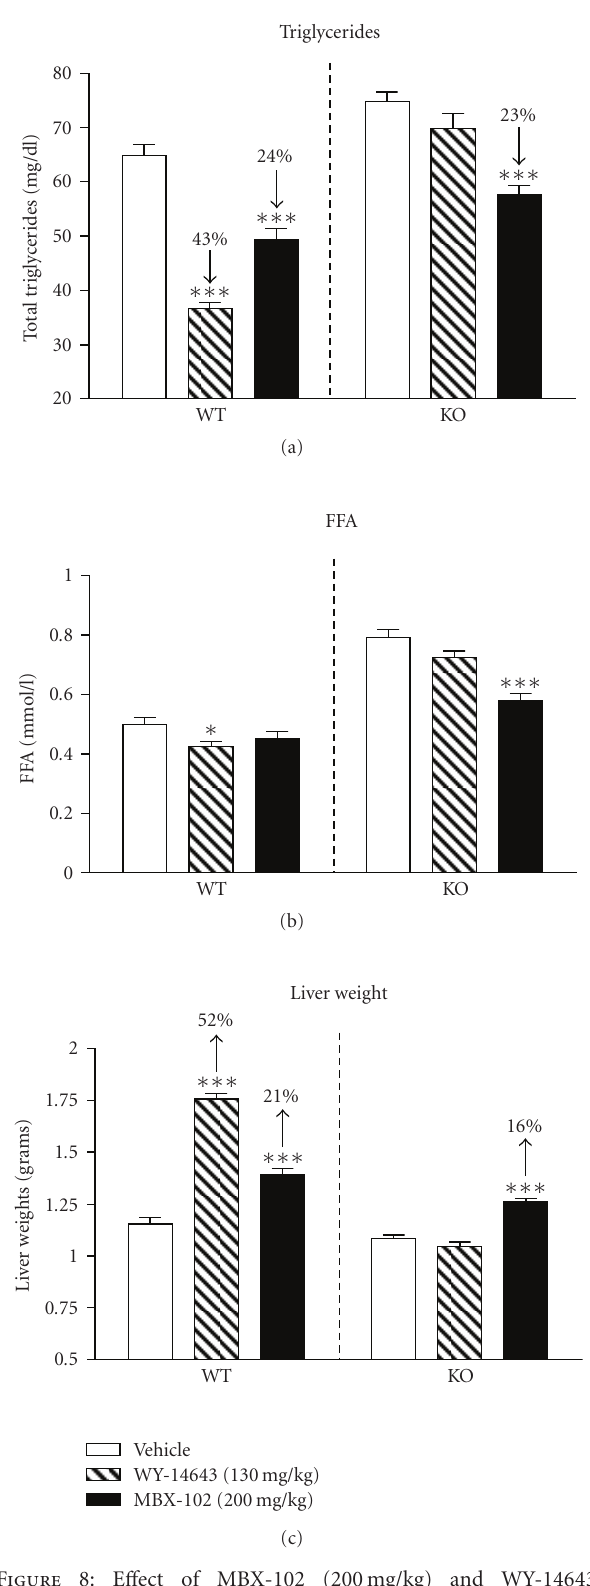
Figure 8: E ff ect of MBX-102 (200mg/kg) and WY-14643 (130mg/kg) on plasma triglyceride levels (a), FFA levels (b), and liver weights (c) in WT and KO mice after 7 days treatment of PPAR- α KO mice. Values represent mean ± SEM ( ∗ : P < . 05, ∗∗∗ : P < . 001 versus Vehicle, 2-way ANOVA, and Bonferroni